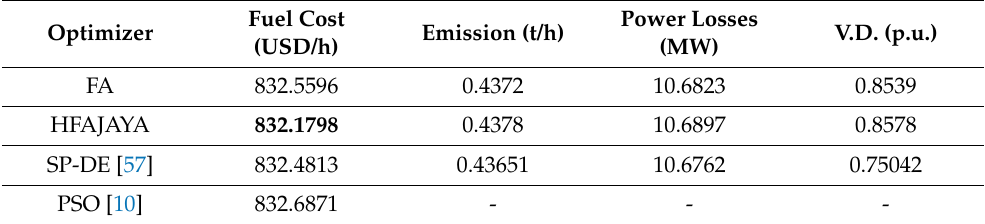
Table 5. The obtained optimal results in the current works for Case